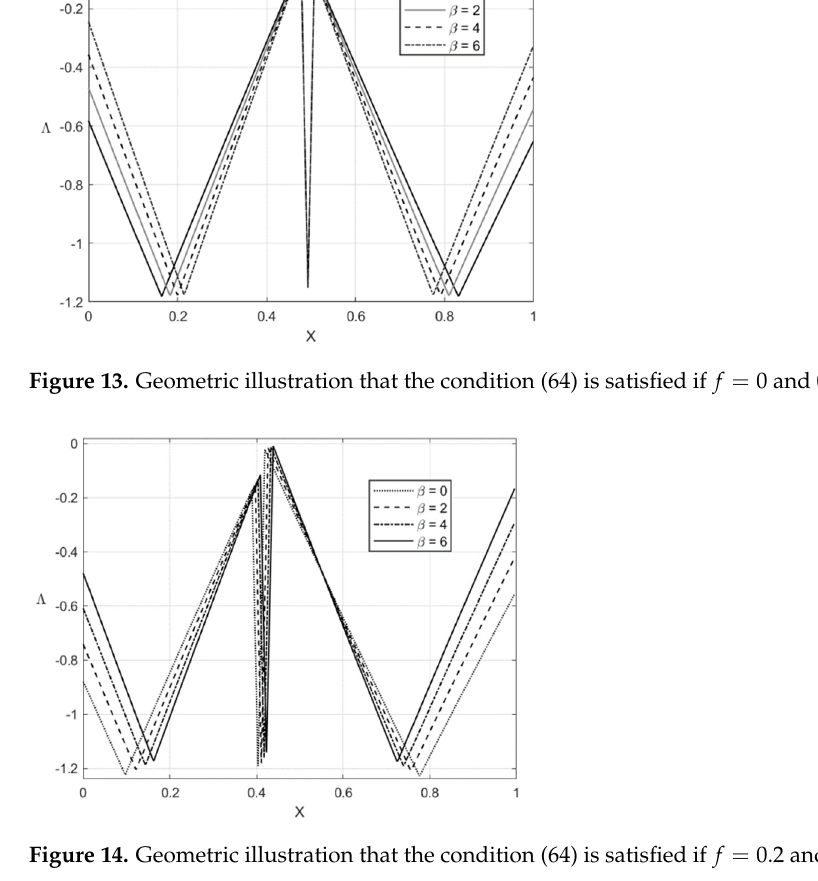
Figure 14. Geometric illustration that the condition (64) is satisfied if f = 0.2 and 0 ≤ β ≤